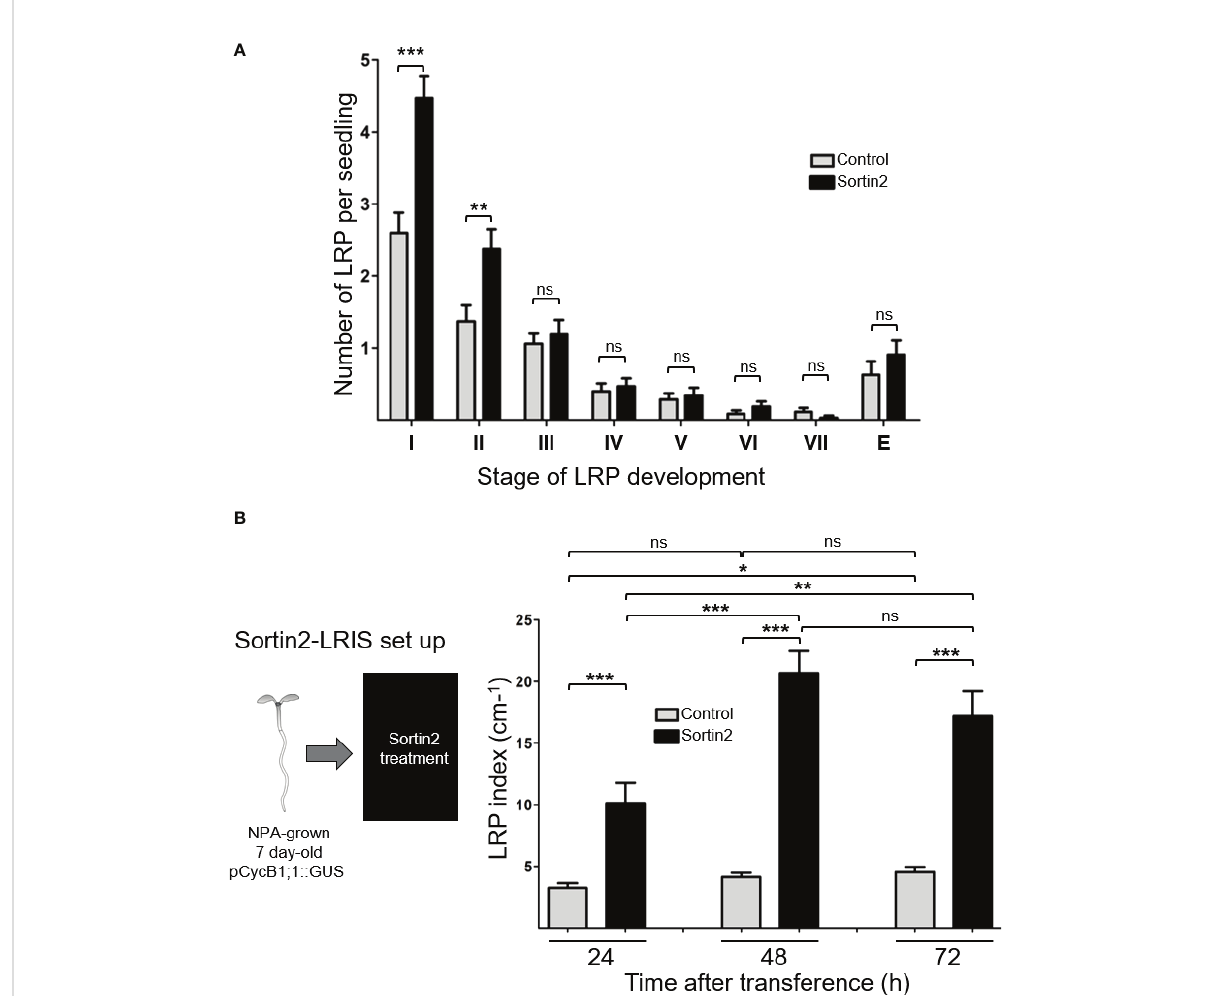
FIGURE 2 Sortin2 promotes lateral root primordium (LRP) initiation. (A) Seven-day-old wild-type (Col-0) seedlings were treated with 25 µg/mL Sortin2 (black bar) for 24 hours or untreated (control; gray bars). The LRPs were scored and classi fi ed into stages from I to VII according to Malamy and Benfey (1997). Emerged LR were also scored (E). Results are from three independent experiments ( n ≥ 32 seedlings). (B) A lateral root-inducible system (LRIS) was used to obtain seedlings without pre-formed LRP. p CYCB1;1 ::GUS seeds were sown in NPA for 7 days. Afterwards, NPA- grown p CYCB1;1 ::GUS seedlings were treated with Sortin2 (black bar) for 24, 48, and 72 hours or untreated (controls; gray bars), and the LRP index was evaluated. The results from fi ve experimental replicates ( n ≥ 26 seedlings) are shown. (A, B) The mean and standard error are shown. The results were analyzed using Student ’ s t -tests; brackets denote statistical differences between conditions (* p < 0.05; ** p < 0.01; *** p < 0.001; ns, not signi fi